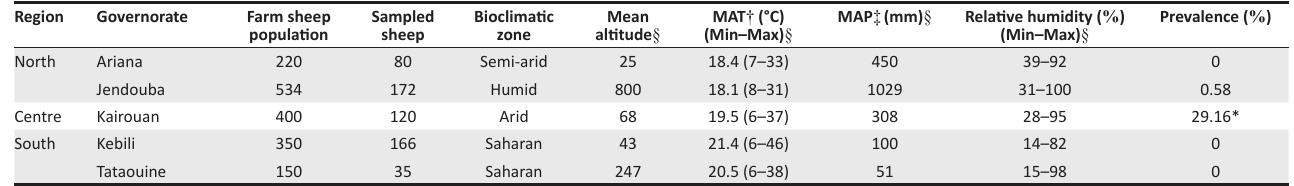
TABLE 1: Geographic and abiotic characteristics of the studied Tunisian areas and corresponding Mycoplasma ovis prevalence in sheep. Region Governorate